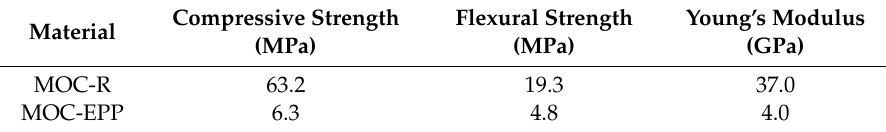
Table 6. Mechanical properties of MOC composites at 28 days of air